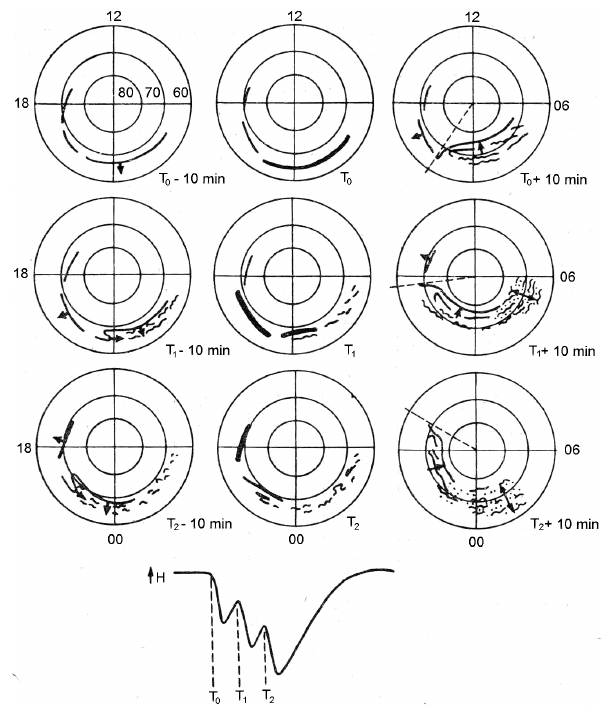
Figure 28. The summary scheme of an auroral substorm devel- opment and a magnetic field H component model (Vorobjev and Rezhenov,